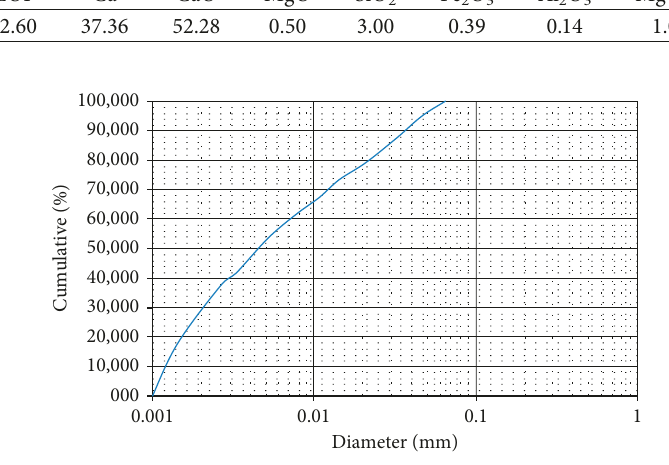
Figure 1: Particle size distribution curve of MP. Table 2: Physical parameters of MP.